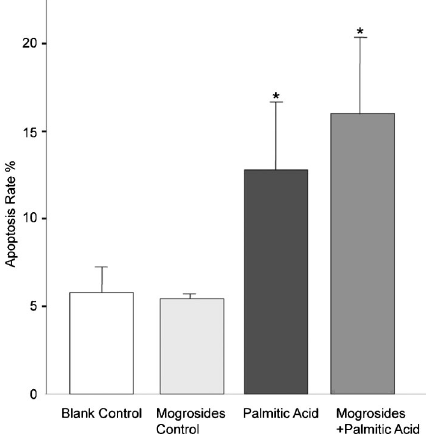
Figure 3. Comparison of apoptosis rates of NIT-1 cells in different groups. Data are reported as the means±SD of percentages for n=3 per group. *P , 0.05, compared to the blank control group (one-way